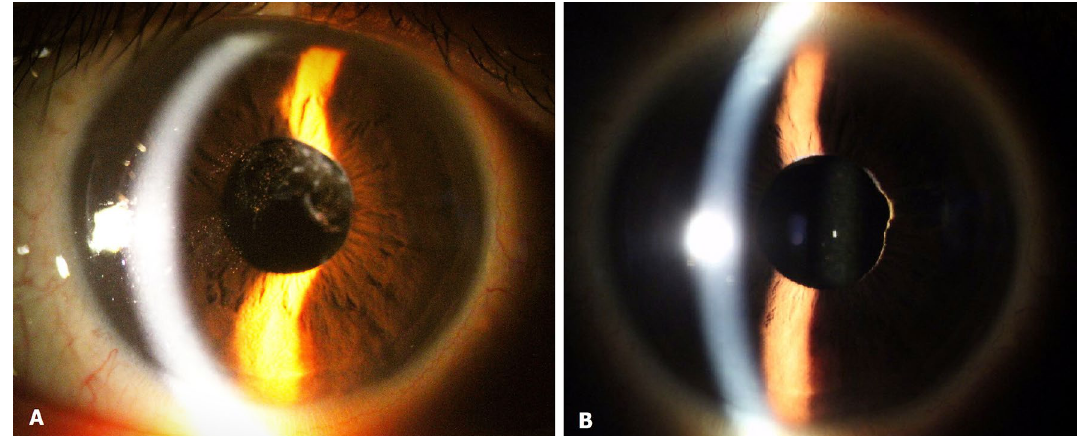
Figure 1. Pre-operative and post-operative external photograph of an eye with vitreous prolapse. The patient was a 55-year-old male who presented with a chief complaint of flashes and increased intraocular pressure of 37.9 mmHg in his right eye. (A) Vitreous prolapse at initial presentation. Pigment cells were observed in the anterior chamber vitreous, but dilated fundus examination revealed no sign of retinal break or detachment. (B) Successfully removed vitreous prolapse after trans pars plana vitrectomy. After the surgical treatment, IOP decreased from 37.9 to 11 mmHg with improved visual discomfort. The notch in the patient’s nasal iris was present before the surgical removal of